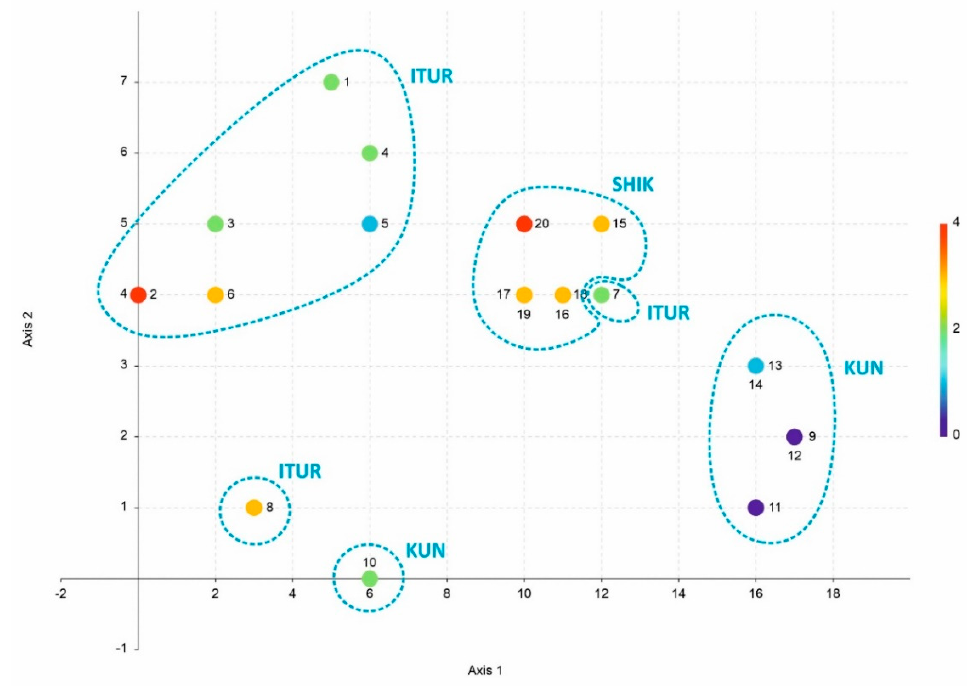
Figure 2. Results of bioclimates (Table S1) comparison by the DCA method.